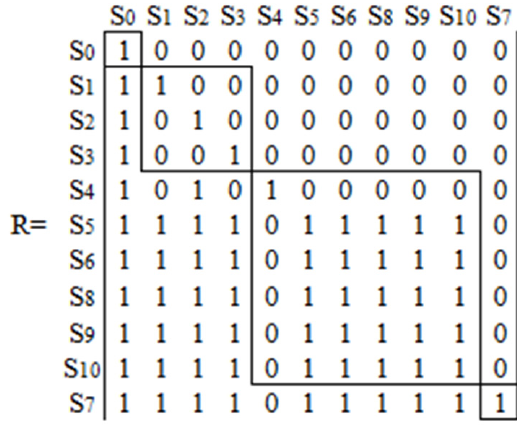
Figure 3. Correlation and Hierarchical Structure Among Influencing Factors of Feeding Rationali ‐ zation. In the same method and step, the correlation and hierarchical structure among the influencing factors of the scientific epidemic control, standardized management and ma ‐ nure recycling can be obtained. The results of the analysis are presented in Figures